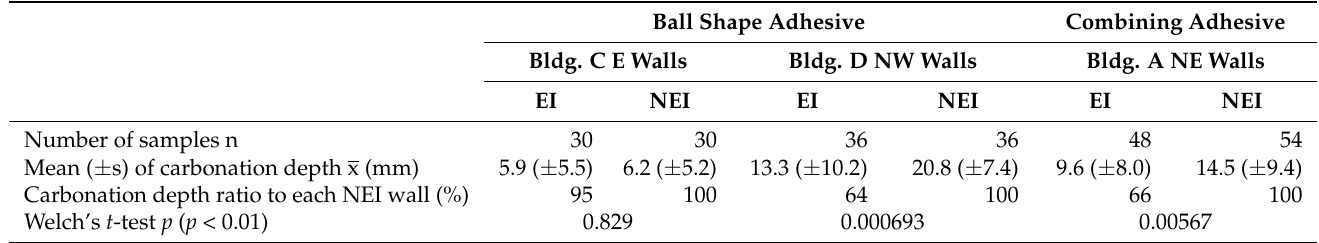
Table 5. Representative values and analysis and test results for each condition of buildings using